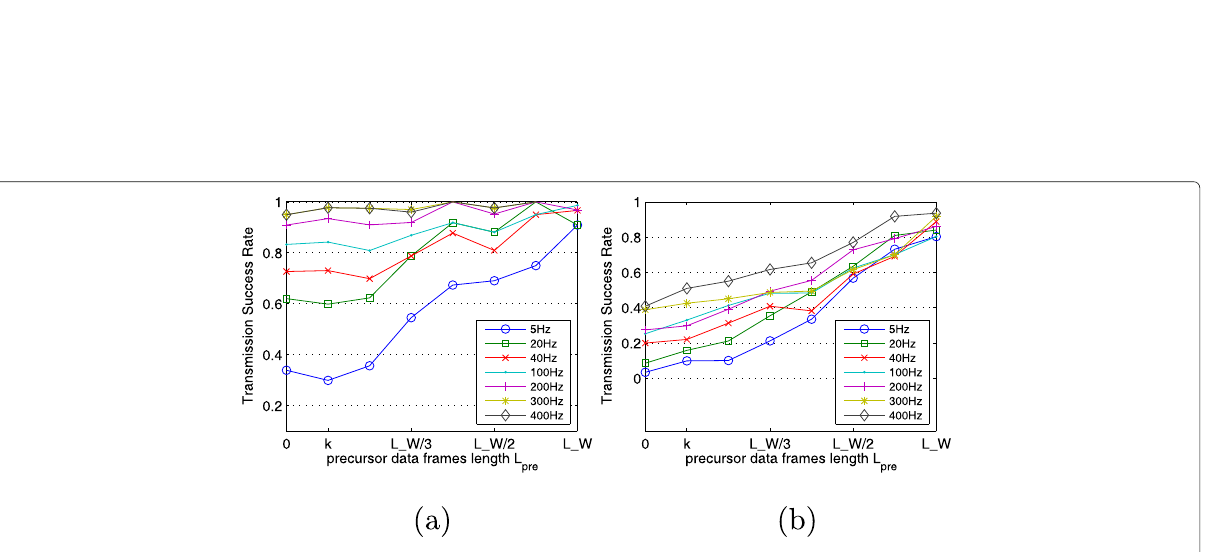
Fig. 9 The success rate with a different number of precursor frames in scenarios A and G